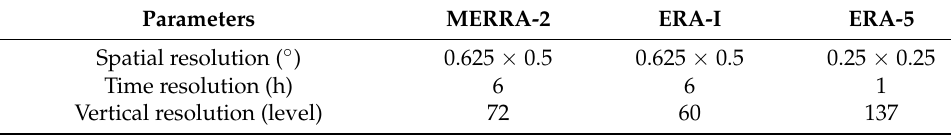
Table 3. MERRA-2, ERA-I, and ERA-5 parameters.